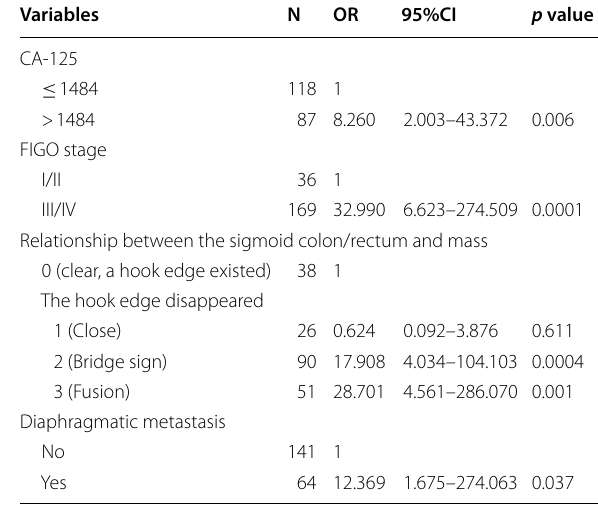
Table 5 Multivariate analysis of clinical and MRI variables